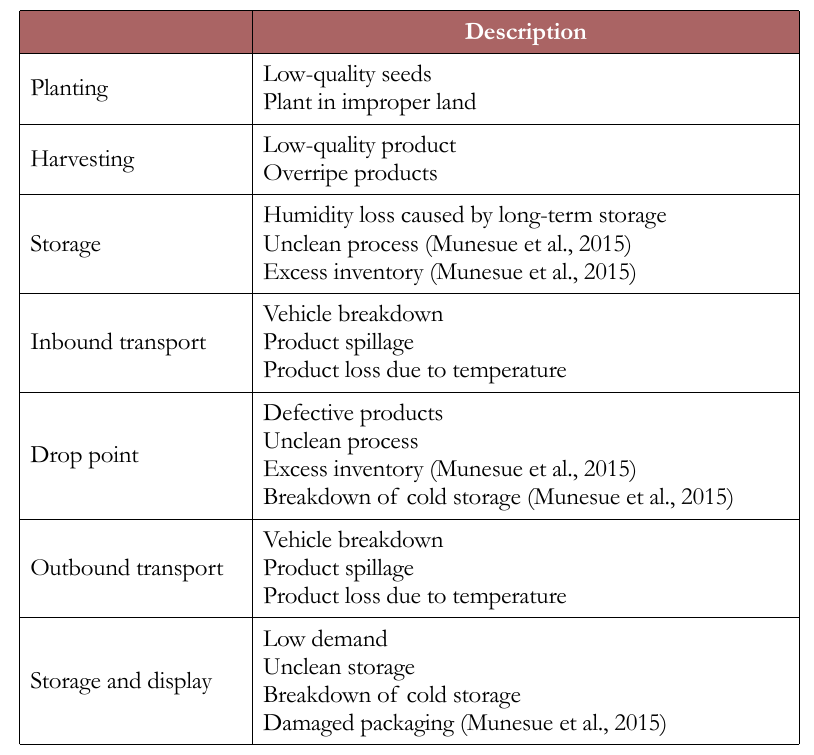
Table 3. Supply chain risk